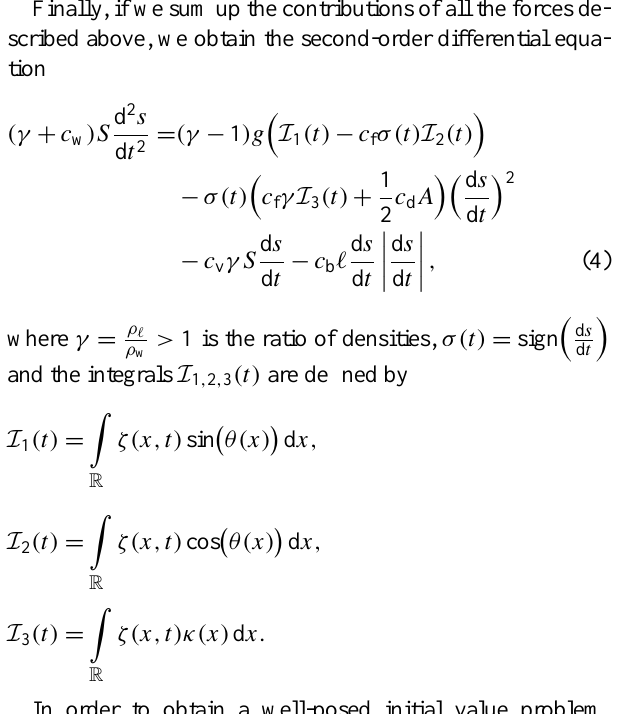
d s N ( x,t ) . d t (cid:19) (cid:18)